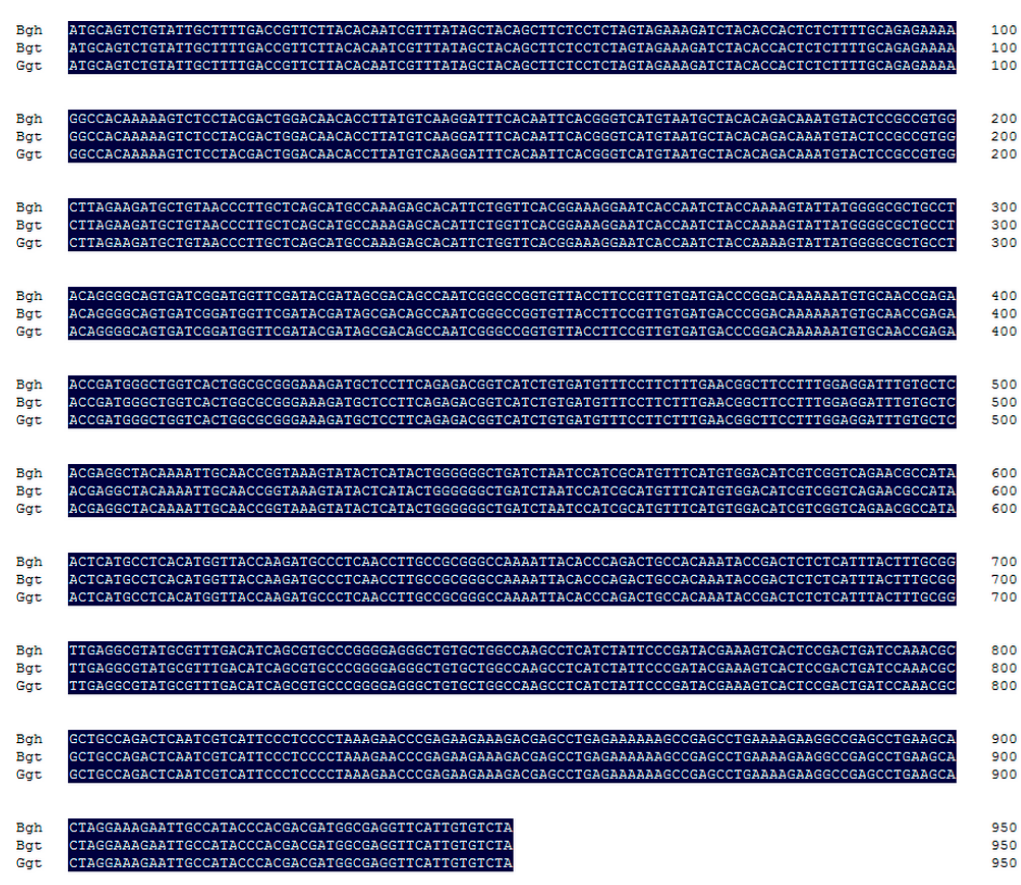
Figure 1. Nucleotide sequences of the homologous genes in Blumeria graminis f. sp. tritici ( Bgt ) and Gaeumannomyces graminis var. tritici ( Ggt ) were completely identical to the BEC1019 sequence in B. graminis f. sp. hordei ( Bgh ).